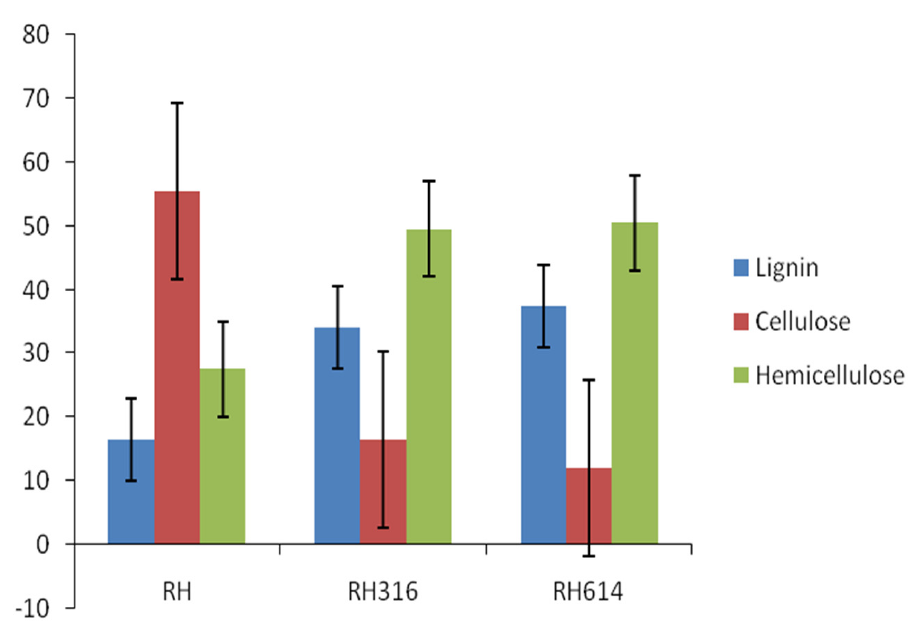
Figure 1. Comparison of LCH contents of raw rice husk and solid digestates.